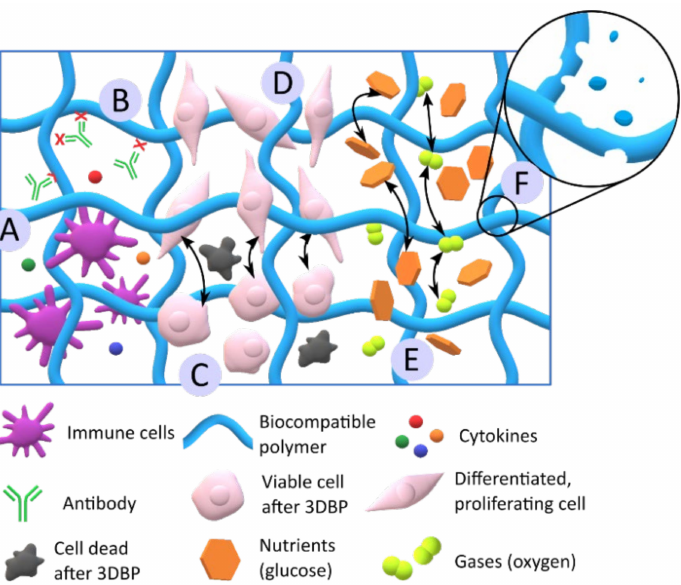
Figure 9. Schematic summary of the main desirable biological features of BIs and BMIs. ( A ) and ( B ) represent low immunogenicity of the BI or BMI, with low/absent cytokine release ( A ) and low antibody recognition ( B ). ( C ) Biocompatibility and cellular viability. ( D ) Cellular proliferation and differentiation. ( E ) The porosity of the BI and BMI allows for nutrients and gases diffusion throughout the 3D construct. ( F ) Construct biodegradability. It is worth highlighting that the degradation process must not result in the production of toxic